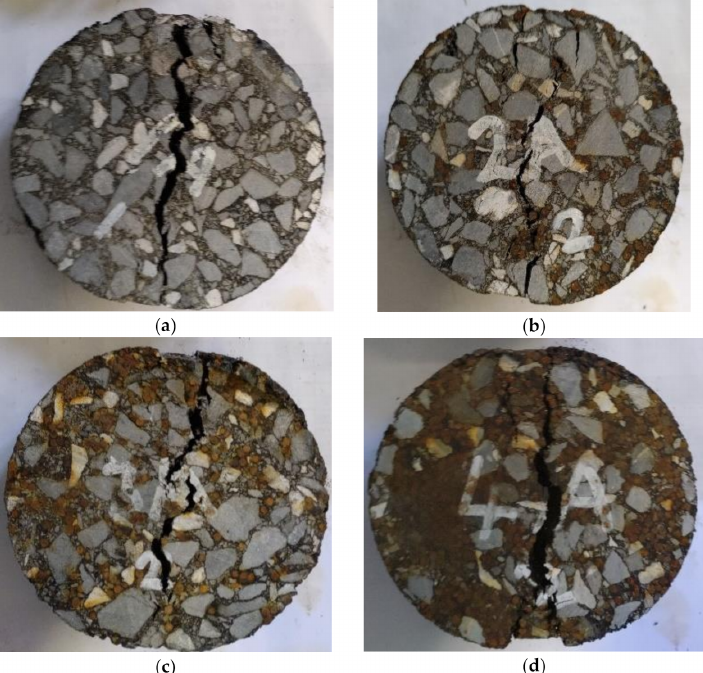
Figure 10. Images of test specimens after ITS test: ( a ) control mix—Mix 1, ( b ) Mix 2–5% capsules,